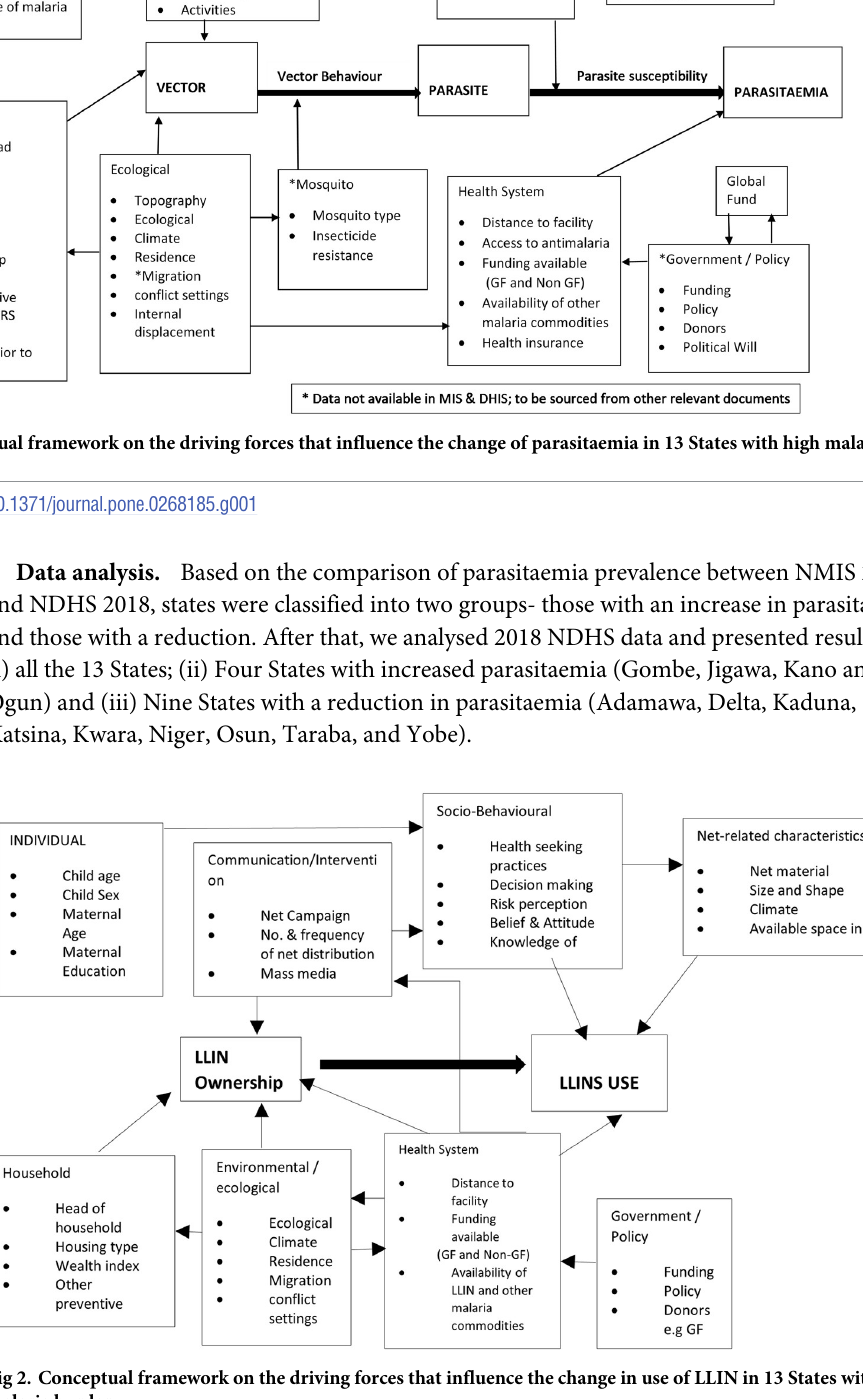
Fig 2. Conceptual framework on the driving forces that influence the change in use of LLIN in 13 States with high malaria burden.